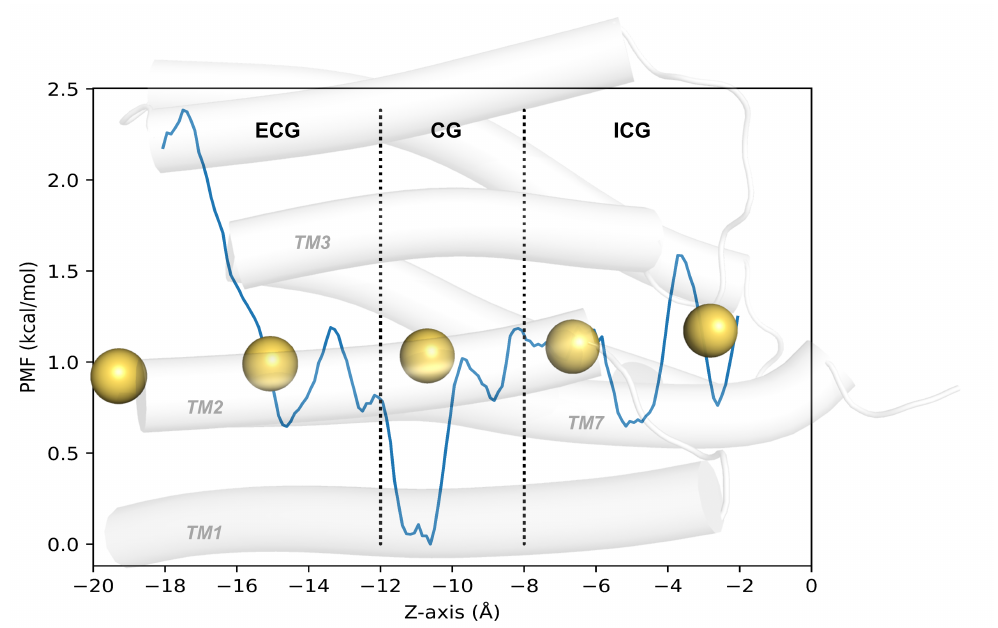
Figure 7. PMF of Na + ions in P520 intermediate. The yellow sphere represents the sodium ion in